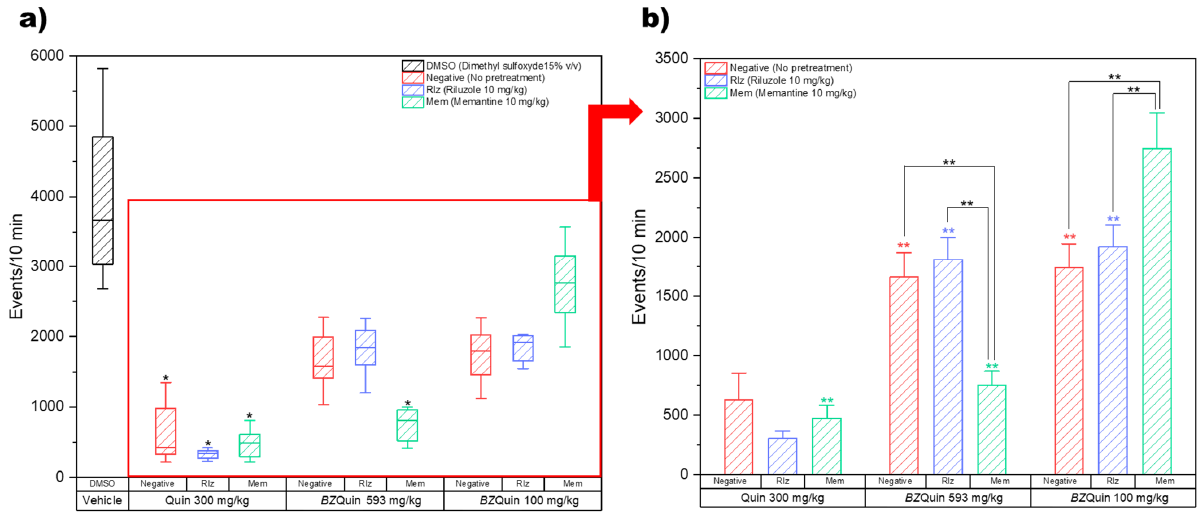
Figure 8. Locomotor activity results (events/10 min). ( a ) Non-normal distribution data considering the vehicle group. * p < 0.05 compared to the vehicle group. ( b ) Normal distribution data not considering the vehicle group. Events/10 min (stimulating agent): BZQuin 100 mg/kg > BZQuin 593 mg/kg > Quin 300 mg/kg, p < 0.001. ** p < 0.01. ** p < 0.01 compared to the negative group with Quin 300 mg/kg. ** p < 0.01 compared to the Rlz group with Quin 300 mg/kg. ** p < 0.01 compared to the Mem group with BZQuin 100 mg/kg.